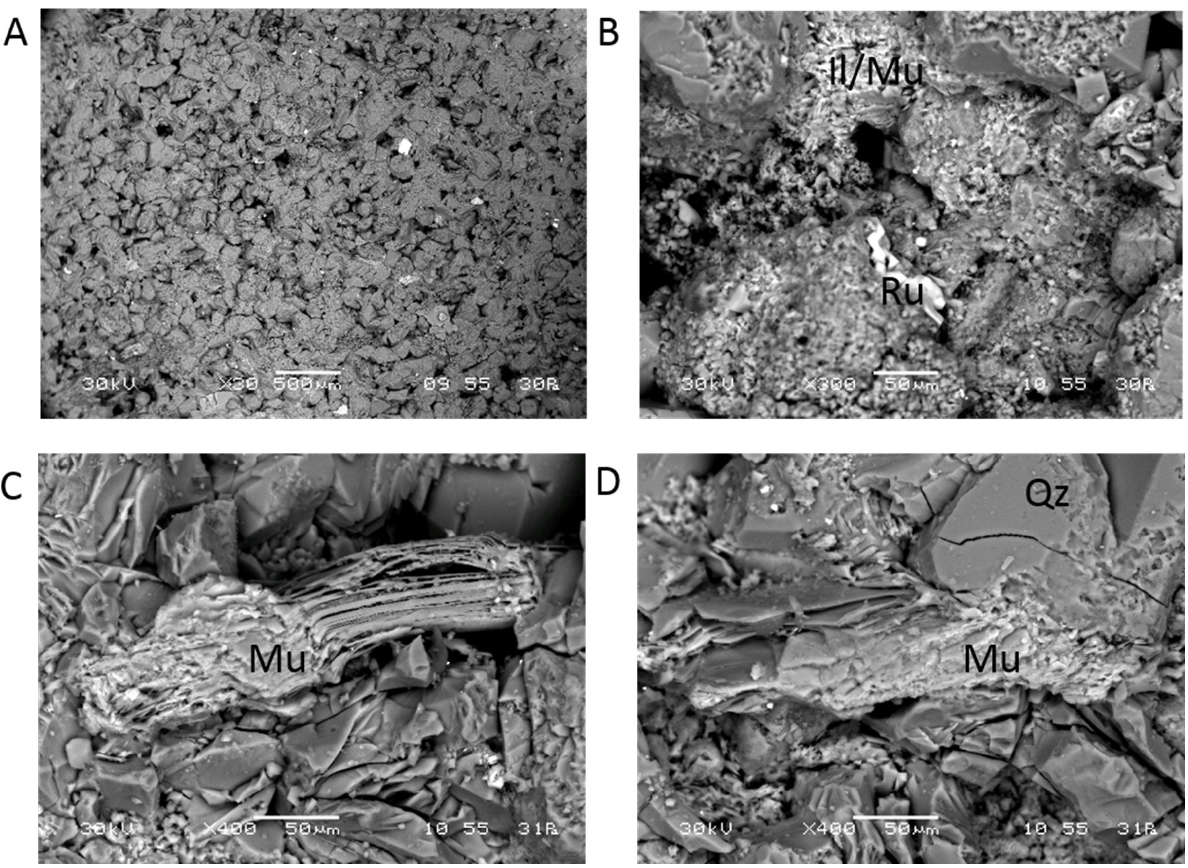
Figure 4. SEM images of the core block surface before the reaction. ( A ) Quartz frame-work grains with intergranular porosity. ( B ) Illite and muscovite partly altered to illite mixed with rutile. ( C , D ) Muscovite booklets. Il/Mu: Ilite and altered muscovite; Ru: Rutile; Mu: Muscovite booklets; Qz: Quartz.